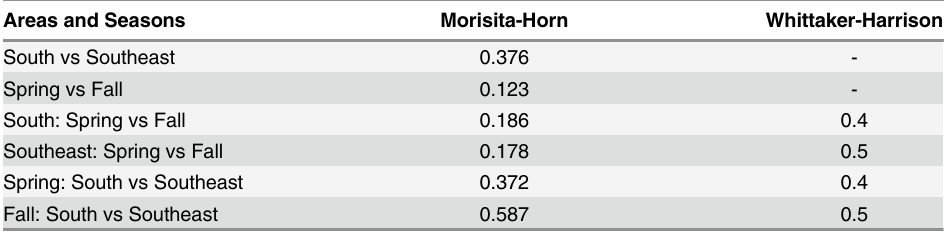
Table 4. Comparisons of beta-diversity indices between areas and seasons in the outer continental shelf and slope in the subtropical Southwestern Atlantic. Areas and Seasons Morisita-Horn Whittaker-Harrison South vs Southeast 0.376 - Spring vs Fall 0.123 - South: Spring vs Fall 0.186 0.4 Southeast: Spring vs Fall 0.178 0.5 Spring: South vs Southeast 0.372 0.4 Fall: South vs Southeast 0.587 0.5 vs, versus to represent comparisons between areas or